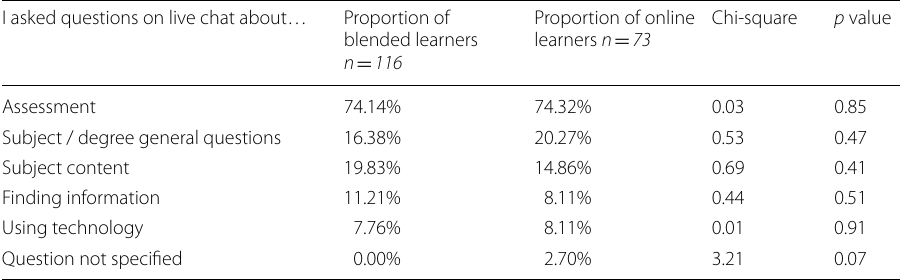
Table 2 What online and blended learners asked questions about on live chat I asked questions on live chat about… Proportion of blended learners